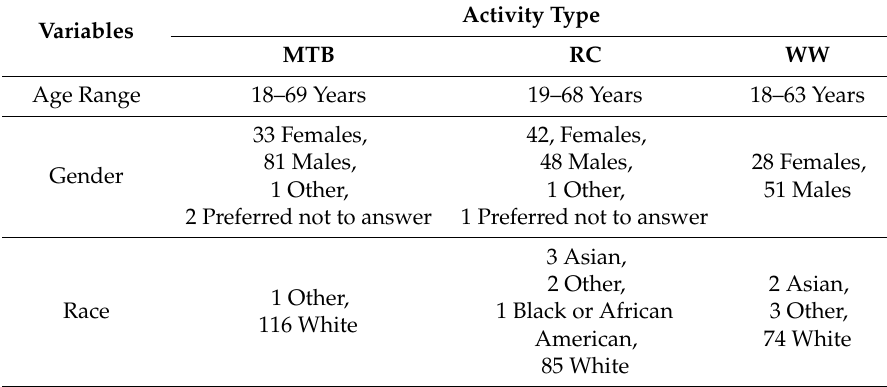
Table 1. Participant sociodemographic